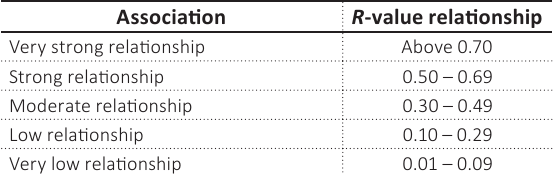
Table 9. R-value interpretation for associations